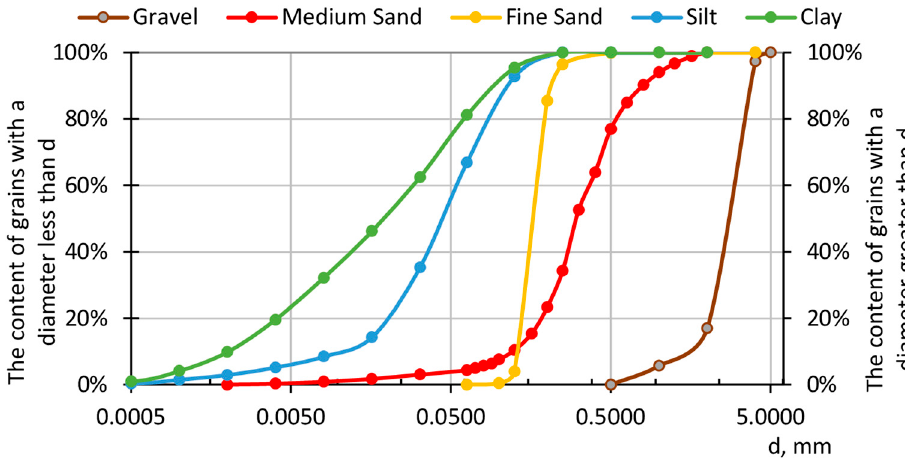
Figure 7. Cumulative grain distribution curves of the tested